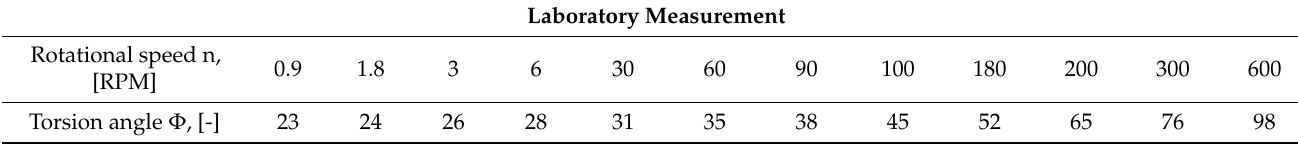
Table 7. Results of laboratory measurements and calculations of shear stresses and shear rates for the tested drilling mud in a 12-speed Fann viscometer 35A/SR-12, with the arrangement of cylinders R1-B1 and spring